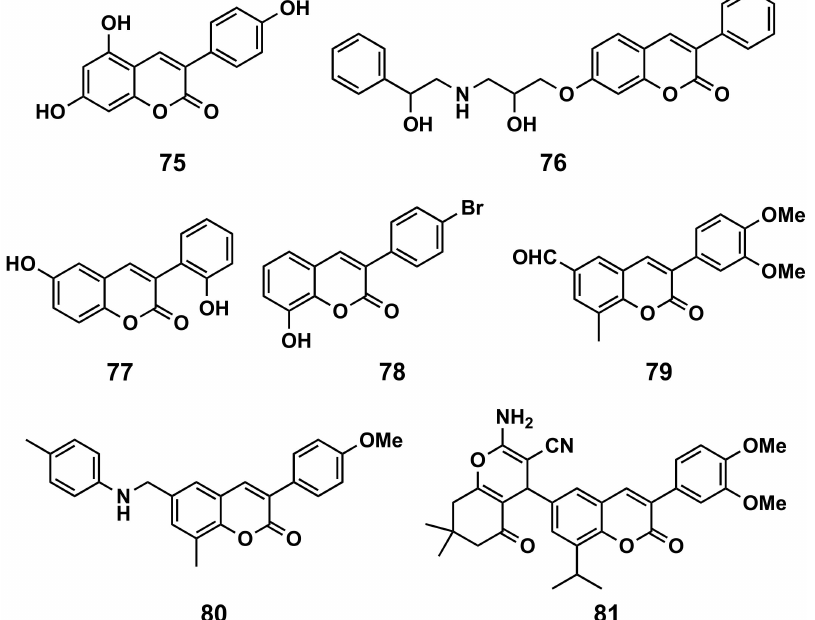
Figure 23. 3-Phenylcoumarins presenting other global pharmacological effects: anti-diabetic agents ( 75 and 76 ), antiallergic ( 77 ), adenosine ligand ( 78 ) and antidepressants ( 79 – 81